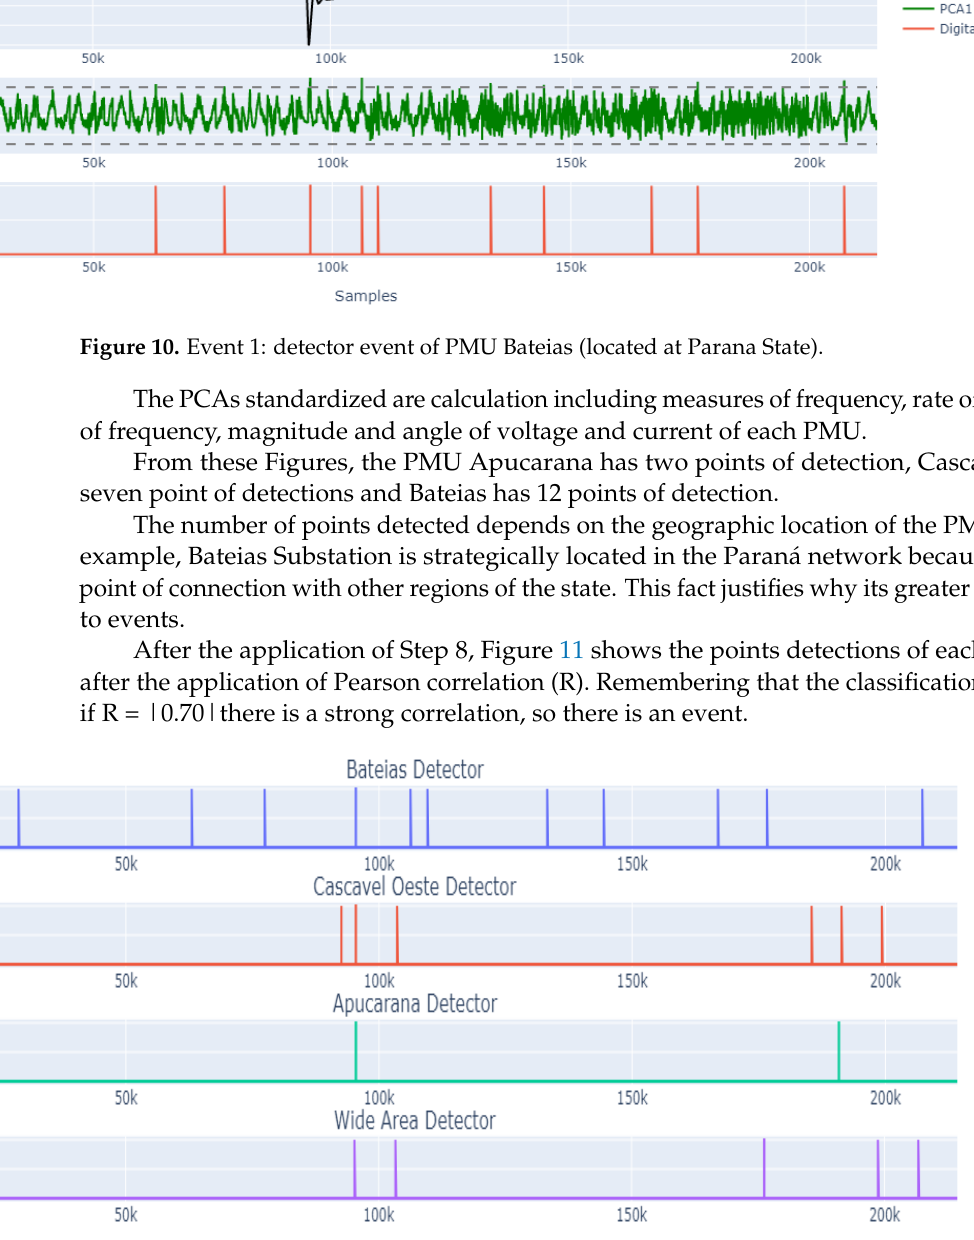
Figure 11. Event 1: PMUS detectors and final detector.